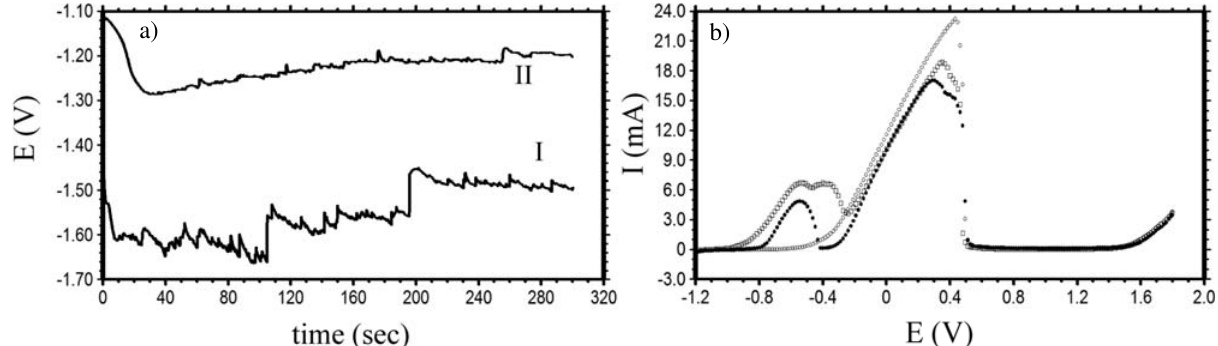
Fig. 1 . The chronopotentiometric curves of ZnFe (I) and ZnFeCo (II) alloy plated electrodes in 3.5 % NaCl solution (a) and the anodic linear sweep voltammograms (ALSVs) of CS ( (cid:2) ), ZnFe ( (cid:3) ) and ZnFeCo ( (cid:4) ) electrodes in 0.50 M Na 23.0 °C, (b), immediately after of exposure